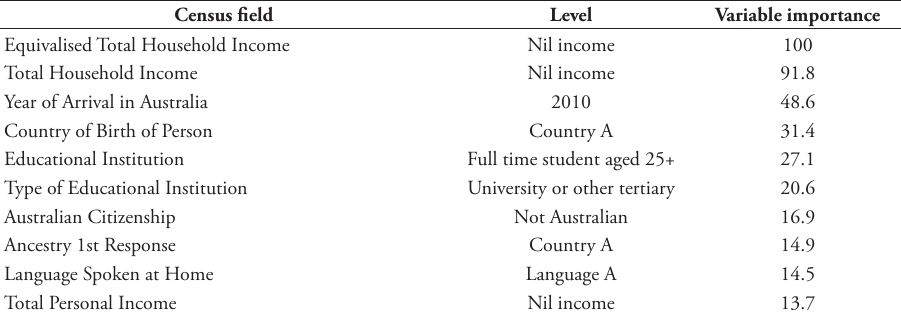
Table 4. Top 10 relative variable importance